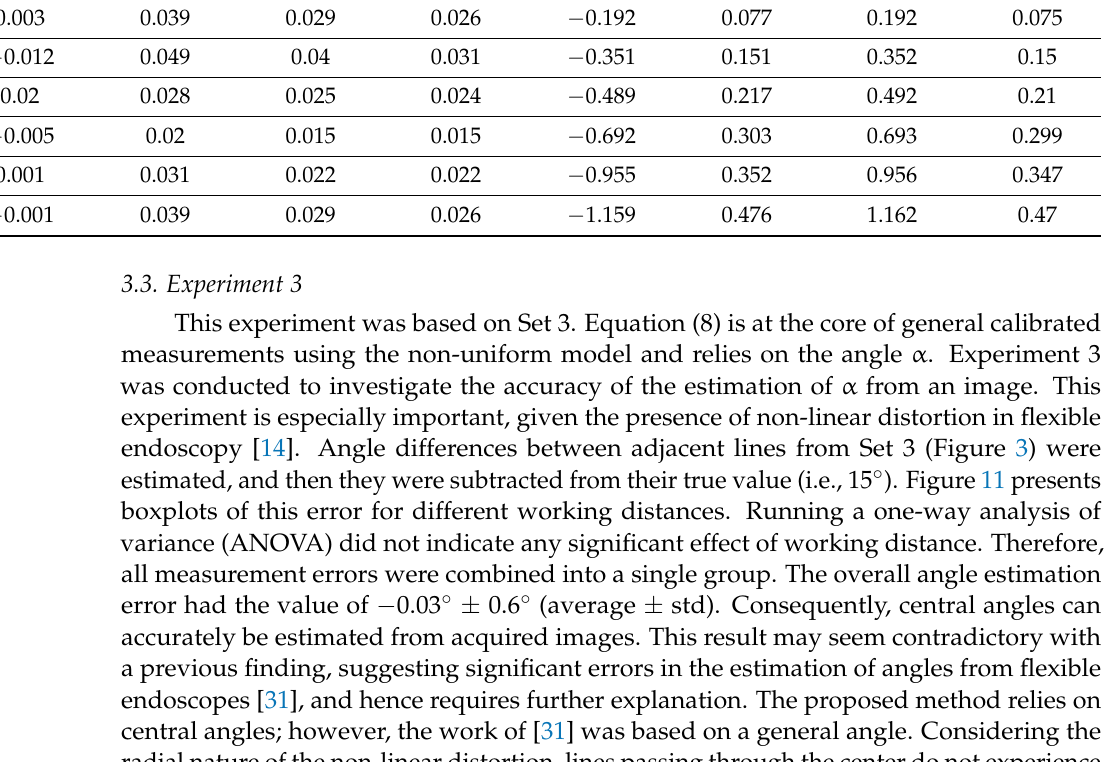
Table 4. Accuracy of radial measurements from uniform and non-uniform models in different ranges of working distance. Working Distance Interval (mm)